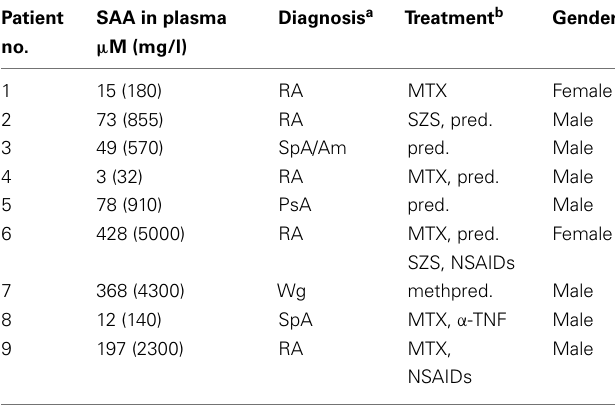
Table 1 | Patients included in the